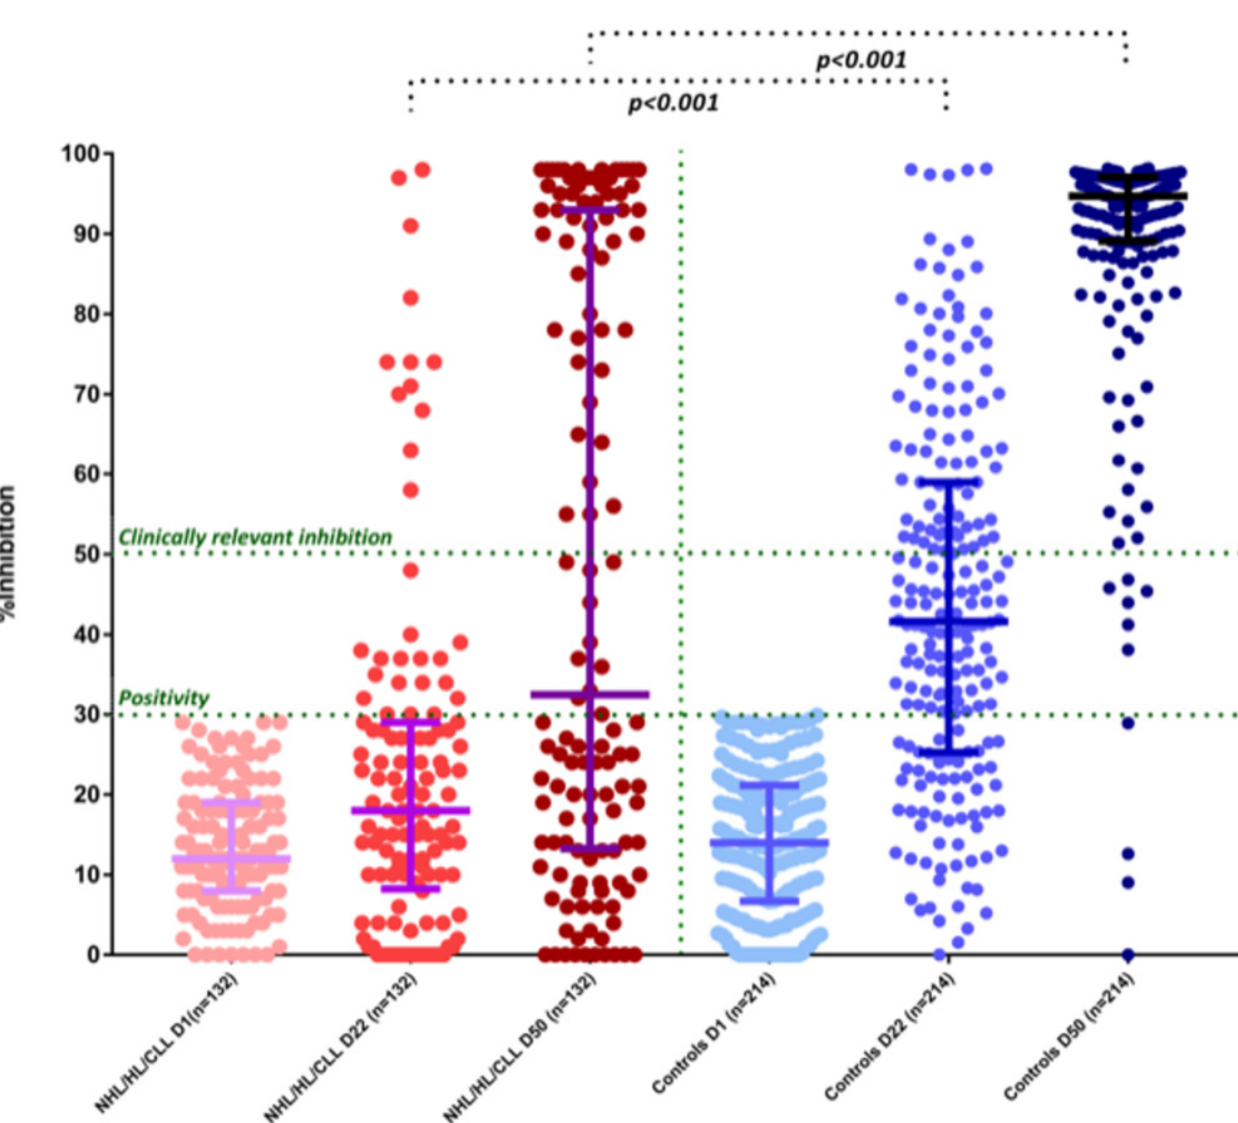
Figure 1. Kinetics of NAbs in CLL/lymphoma patients compared with controls after vaccination with 2 doses of the BNT162b2 (post hoc mixed-model repeated-measures analysis). On D22, patients had lower NAb inhibition titers compared with controls (see text). Only 12/132 (9%) patients had NAb titers of equal or more than 50%. Similarly, patients had lower NAb inhibition titers compared with controls on D50 (see text). Only 58/132 (43.9%) patients had NAb titers of equal or more than 50%.